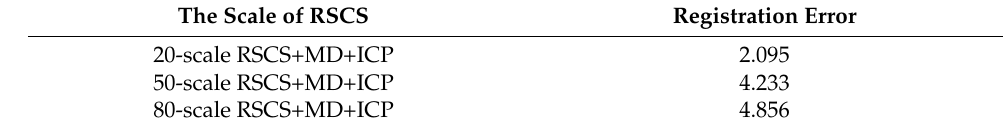
Table 1. Influence of RSCS at different scales on parts registration error (mm).